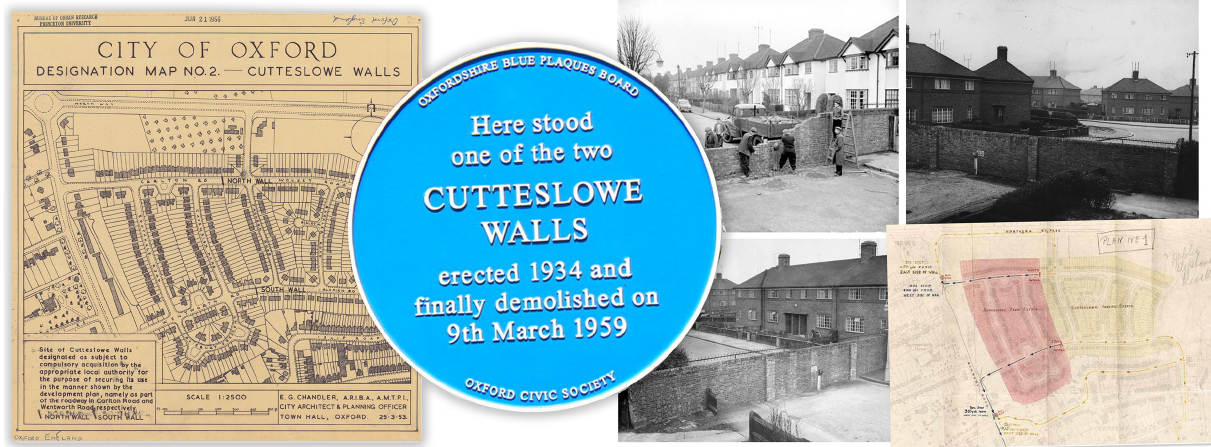
Figure 3. Example extract from a UK case study collected at Stage 2a (Figure 2) of the study. In 1933, the City of Oxford sold a site to a private developer who consequently constructed several brick walls that blocked any direct links with the adjacent public housing estate; this was reportedly in response to impacts ranging from “privacy” to the “protection of property values” (Organic, 1964, p. 112). It took post‐war changes in compulsory purchase legislation of the land on which the walls stood and 11 years of legal challenges for the City Council to remove them, albeit the physiological barriers seem‐ ingly remained for a lot longer (Collison, 1963). Source: Photos and maps from Bowie (2018) and Hall (2018). geographers, civil engineers, and architects drawn from diverse geographic and working backgrounds. At each stage, participant presentations and views expressed in discussion were digitally recorded and transcribed for the purposes of thematic analysis.